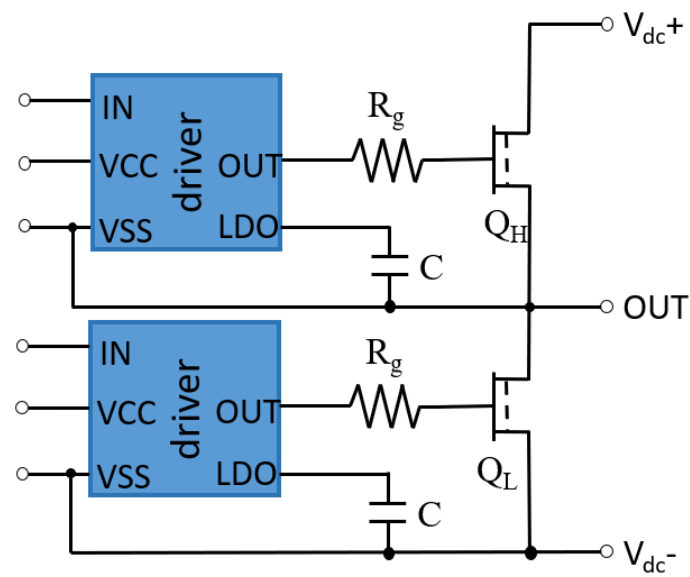
Figure 1. Schematic of the integrated GaN half-bridge module. To reduce the trace length of the driver loop and obtain lower inductance, two modules were fabricated with integrated driver dies. The difference between these two modules is that the driver loops of the two modules were packaged either by the wire bonding process or using flip-chip technology. A microscope photograph of the driver loop packaged by wire bonding is shown in Figure 2a. The diameter of the bonding Au wire was 20 µ m. The capacitor and resistor were interconnected with the substrate by surface mount technology (SMT) in this module. The distance between the out terminal of the driver and the gate of the HEMT device was more than 4 mm. As shown in Figure 2b, the driver die in the other module was packaged by flip-chip technology through gold balls. The diameter of the gold balls was approximately 60 µ m. A capacitor was set on the reverse side of the substrate by SMT, and a tantalum nitride (TaN) film was used as the gate resistor on the substrate. The distance between the out terminal of the driver and the gate of the HEMT was as short as 1.3